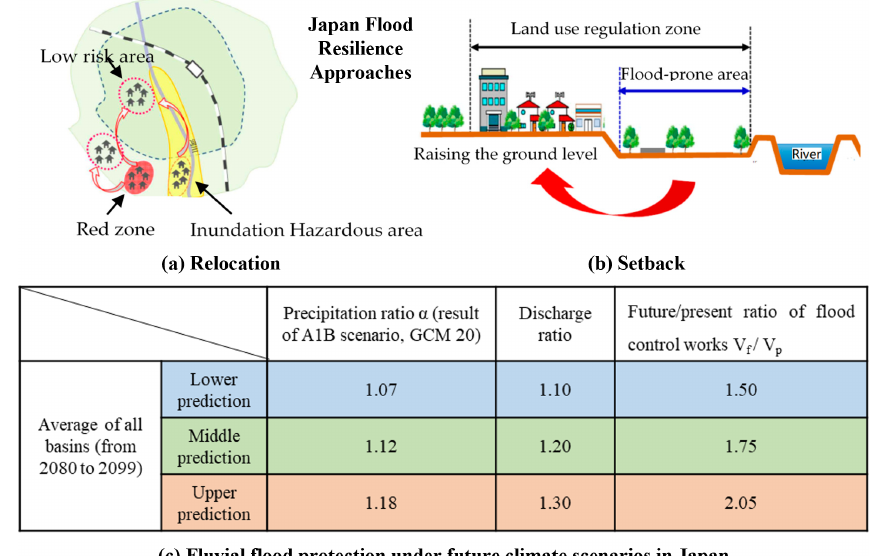
Figure 3. Flood resilience approach in Japan for (a) relocation and (b) setback strategies to protect residents and (c) fluvial flood prediction with future climate projection (adopted from MILT, 2008, 2013; Fan and Huang,